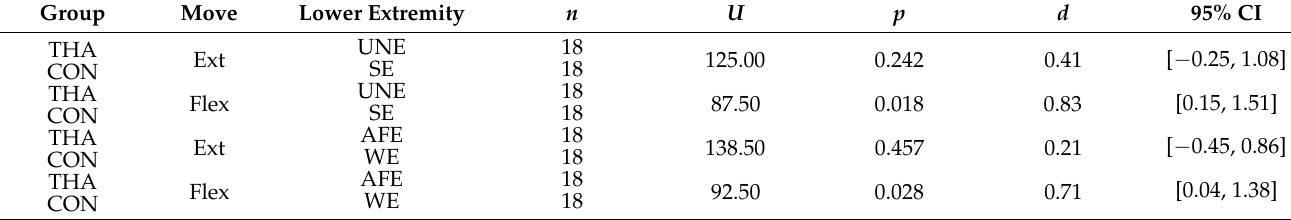
Table 3. Assessment of the extensor and flexor muscle strength imbalances between groups. Group